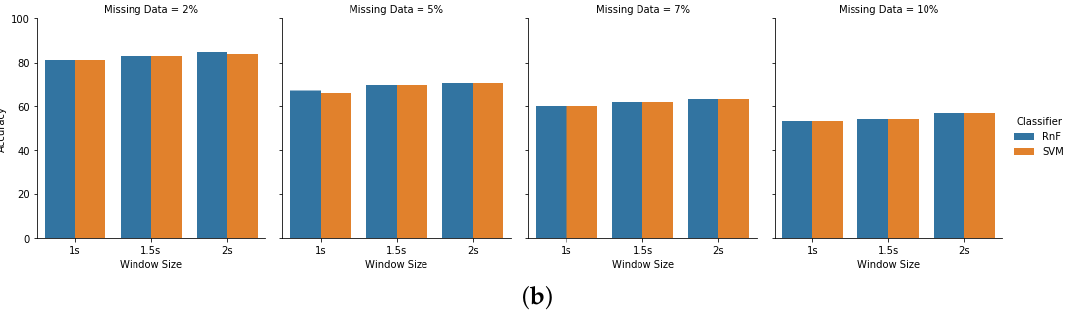
Figure 11. Evaluation of the single chest dataset for window size 1 s, 1.5 s, and 2 s. Missing percentage 2%, 5%, 7%, and 10% in two scenarios: ( a ) single Chest dataset for the traditional approach; ( b ) single chest dataset for the proposed